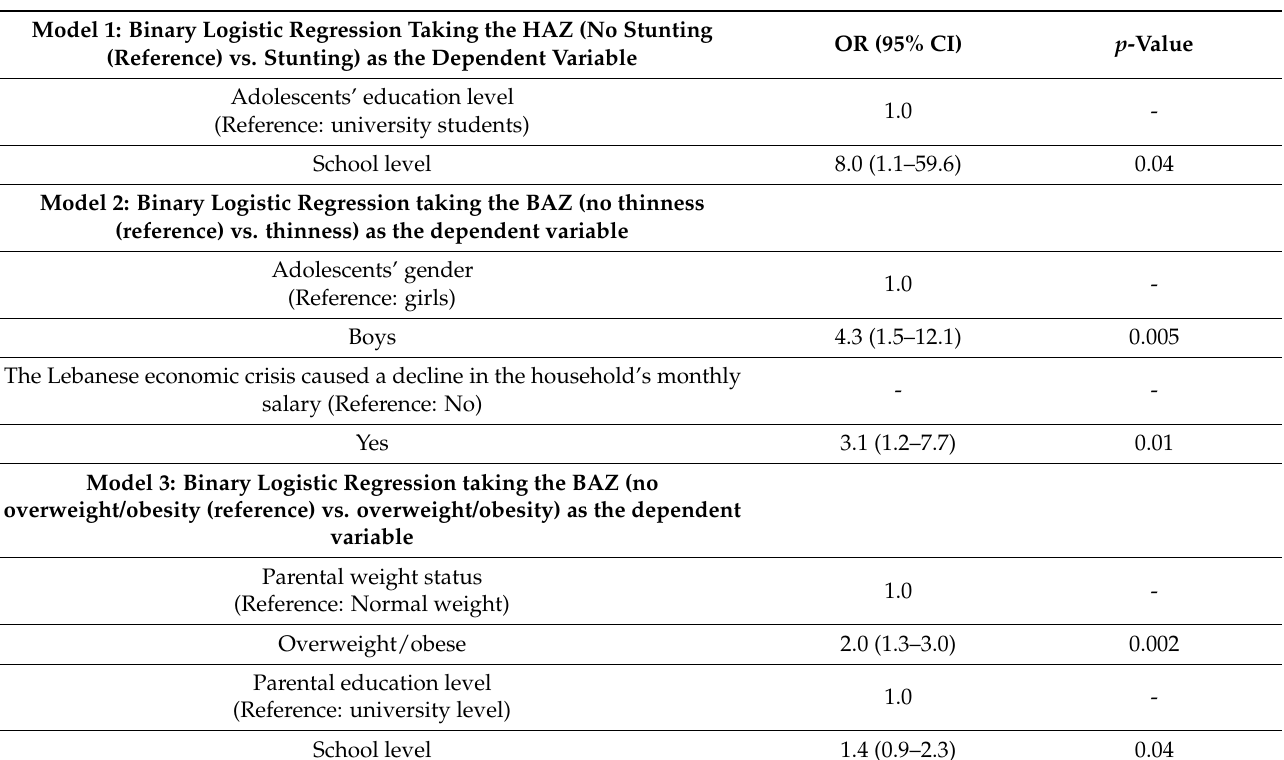
Table 3. The determinants of adolescents’ nutrition status and adolescents’ self-reported FI: binary logistic regression